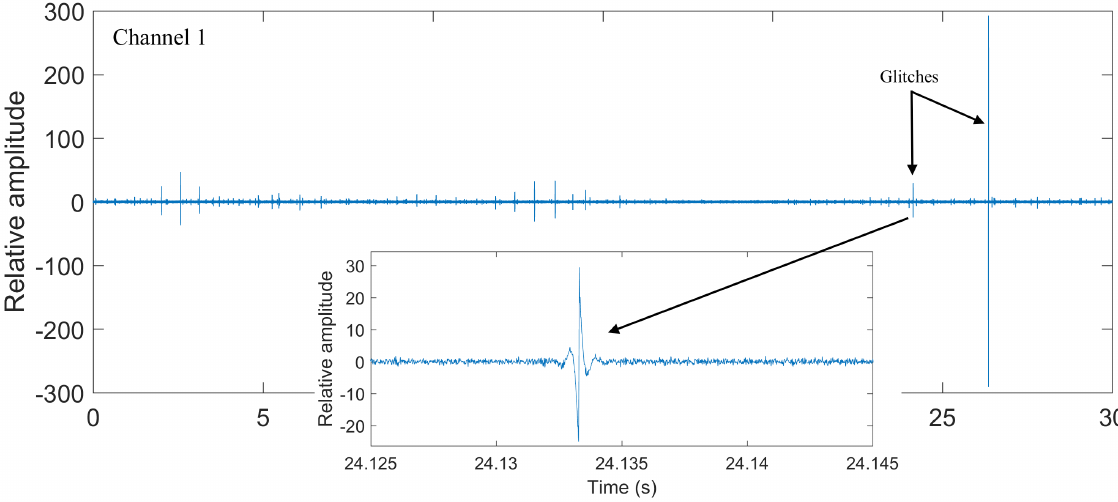
Figure 8. Time series recorded on channel 1 for the same 30s of data shown in Fig. 7. The two glitches present are indicated by arrows. The inset shows detail of one of the glitches. Regardless of the amplitude, which can be comparable to the amplitude of odontocete echolocation clicks, they all have the characteristic shape shown here, which is distinctly different from that of echolocation